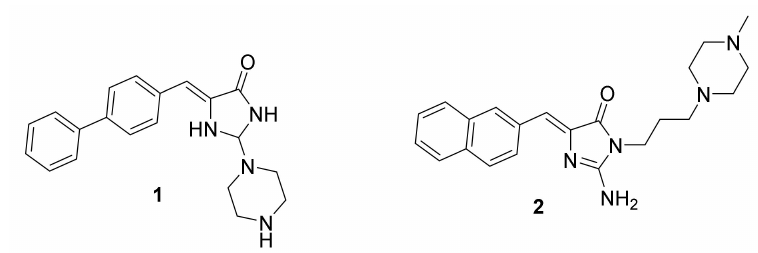
Figure 1. 5-Arylideneimidazolones able to block mechanism of bacterial multidrug resistance (MDR) ( 1 , 2 ) [21,22].